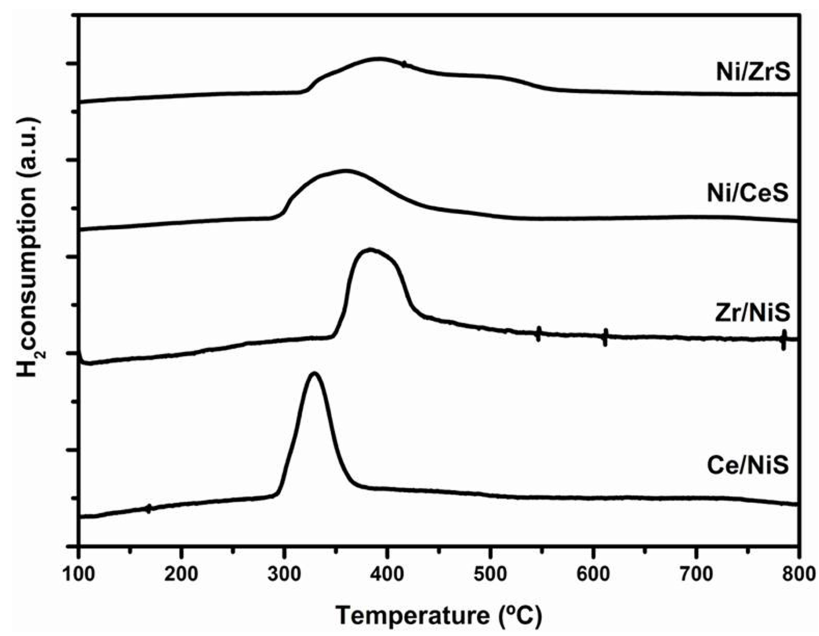
Figure 5. Temperature programmed reduction (TPR) profiles of the calcined Ce- or Zr-modified Ni/SiO 2